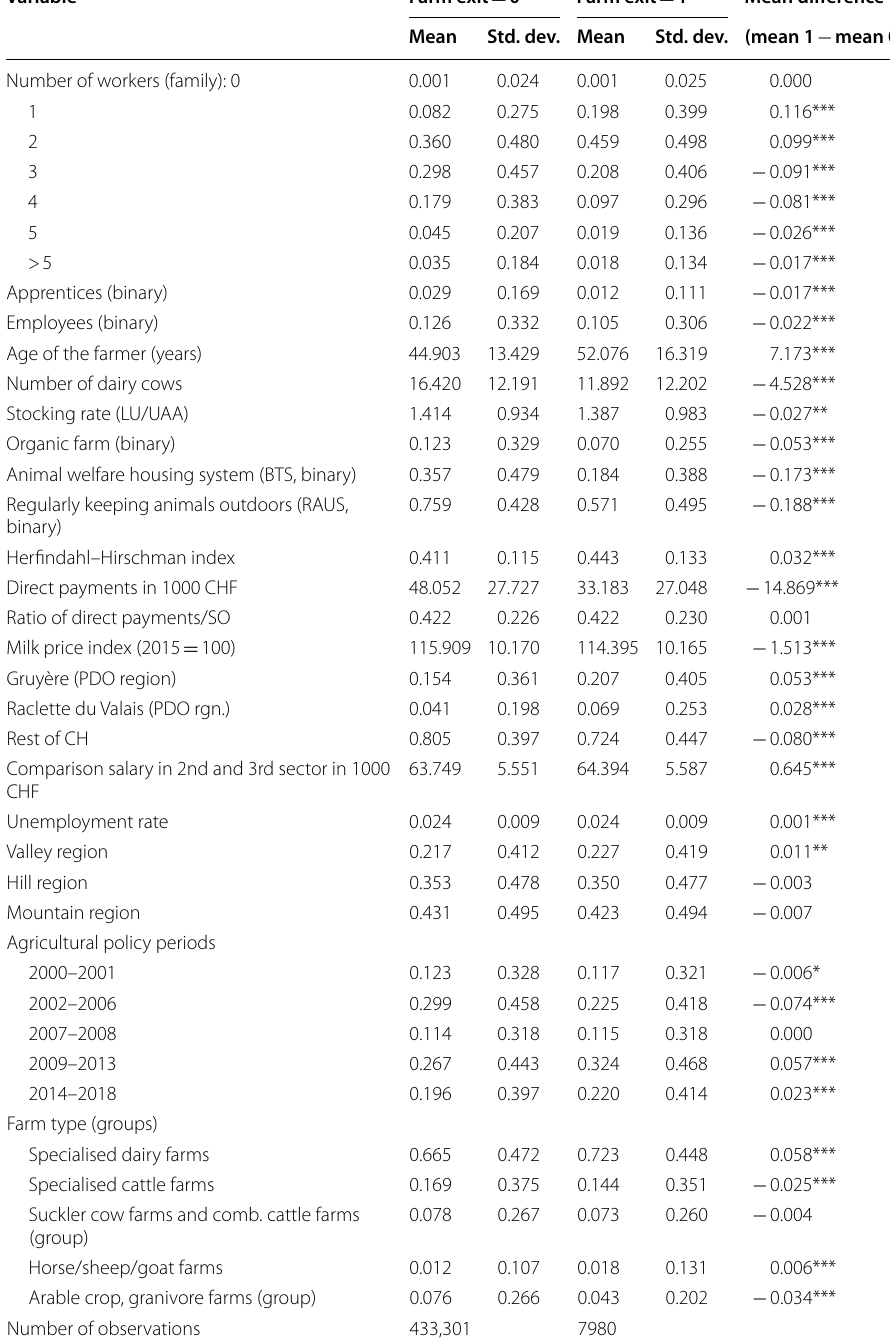
Table 5 Summary statistics of staying and leaving farms. Source : Authors’ calculations based on AGIS 2000–2017, milk price data from the FSO and unemployment data from the